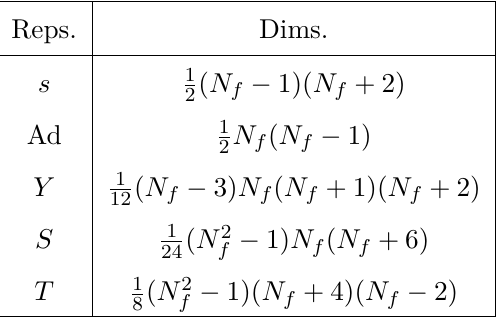
Table 2 . Representations in SO( N f ) and their